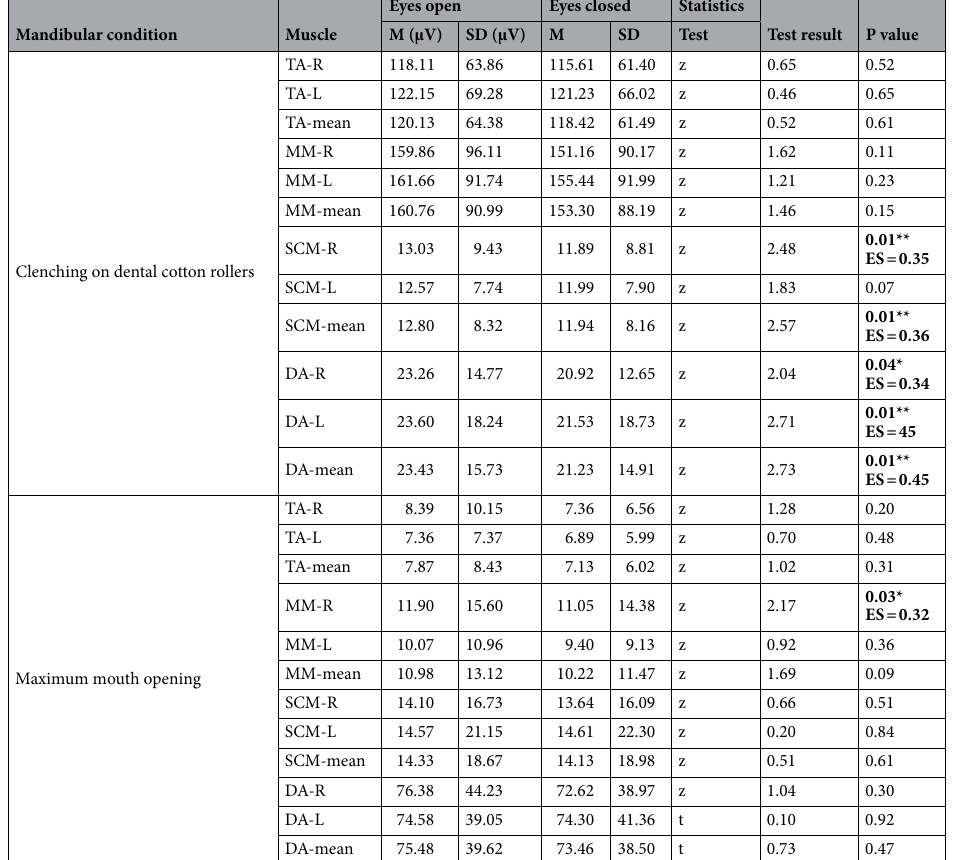
Table 2. Presenting summary of the results of bioelectrical activity (clenching on dental cotton rollers and maximum mouth opening) of the studied muscles. Significant values are in bold. TA the front part of the temporalis muscle, MM the superficial part of the masseter muscle, SCM the middle part of the sternocleidomastoid muscle, DA the anterior belly of the digastric muscle, R right site, L left site.